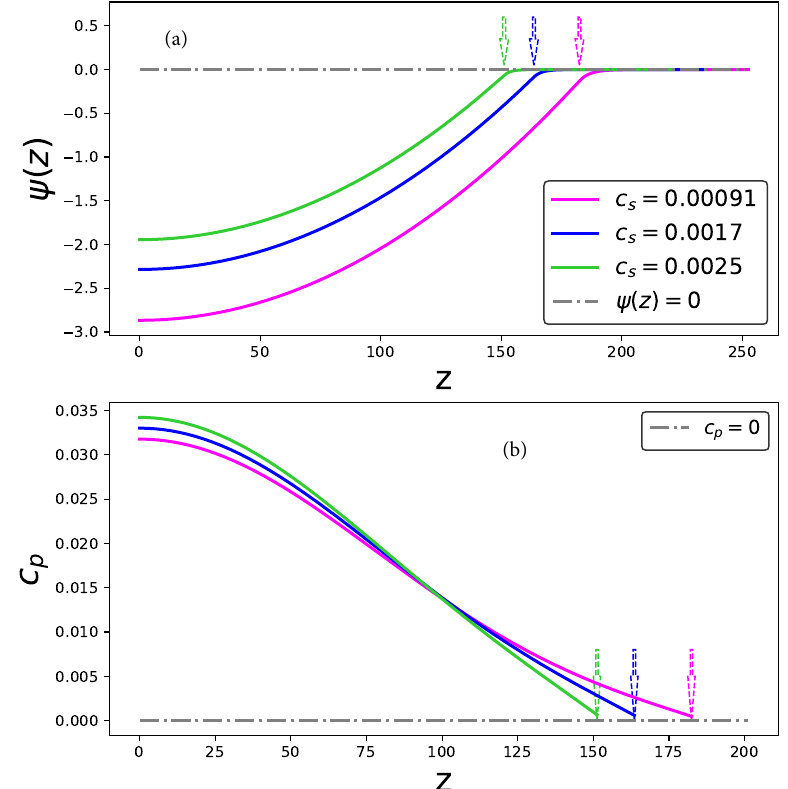
Figure 8. Electrostatic potential of the polyanionic brush ( a ) and the distribution of the monomer c p ( z ) density c p ( z ) inside the brush ( b ) as a function of the distance from the grafting surface z and varied salt concentration C s ≡ c s a 3 for N = 300, s / a 2 = 100. The brush boundary, z = H , is indicated by the